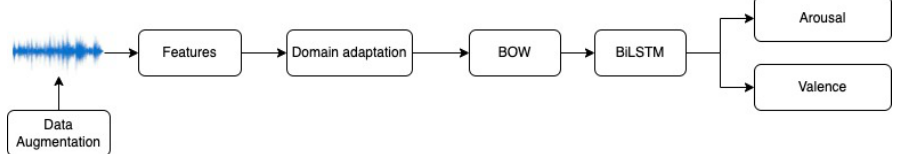
Figure 1. Block diagram of the cross-language SER systems combining BoW and domain